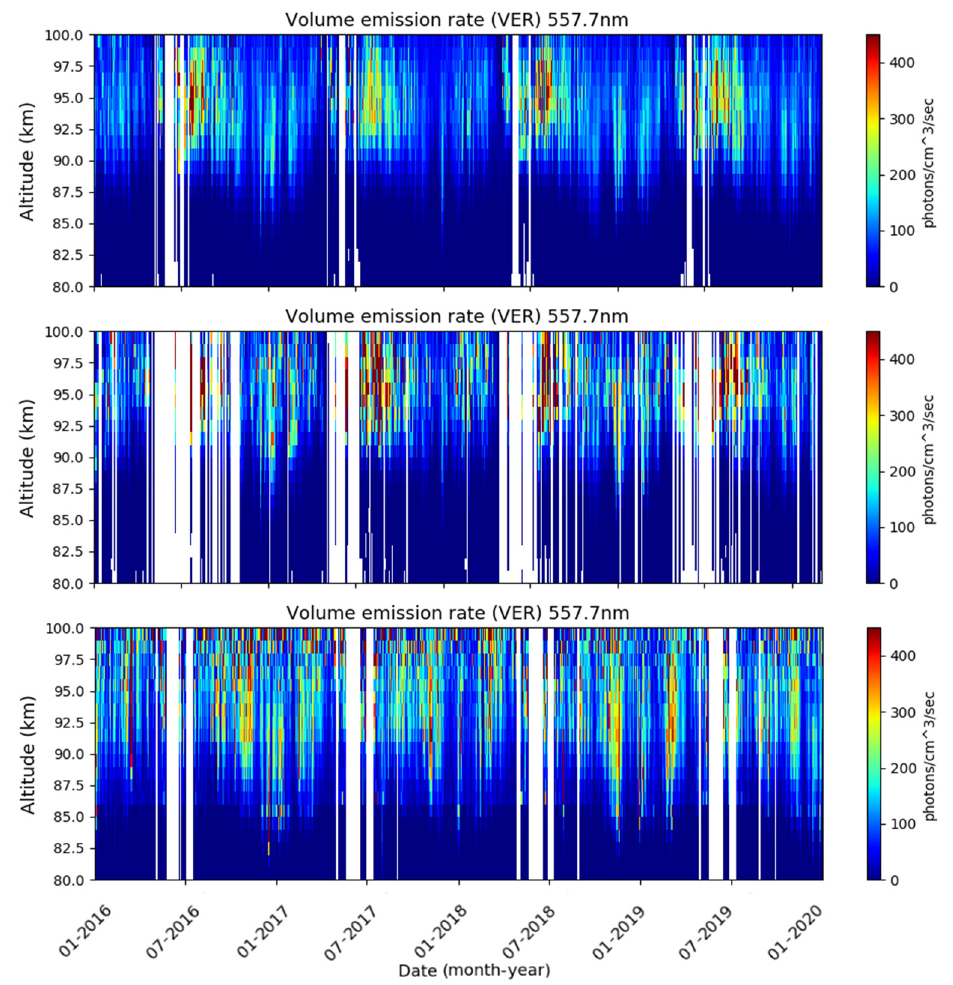
Figure 7. Dynamics of height profile of the atomic oxygen 557.7 nm line airglow over 2016–2020 above GPO in Tory, nighttime. Top panel is based on data calculated using oxygen by [20], middle panel is based on data calculated using oxygen by [24], and bottom panel is based on data calculated using oxygen by [25].